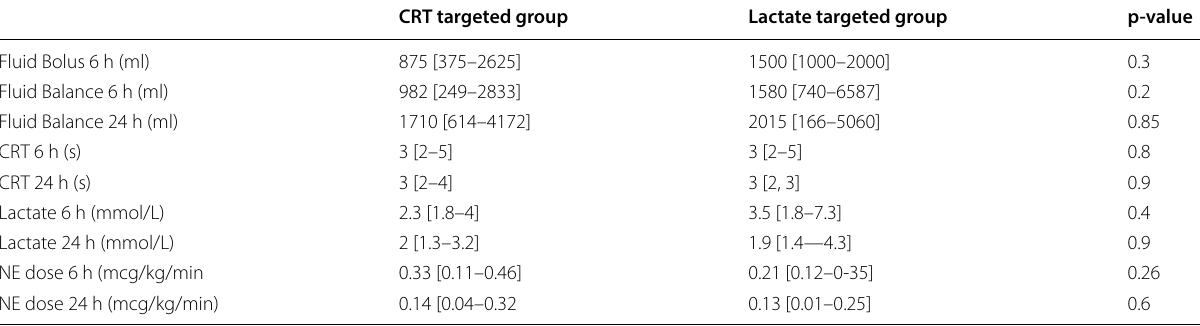
Table 2 Fluid administration, balance, perfusion targets and vasopressor dosage in both randomization arms during the study period